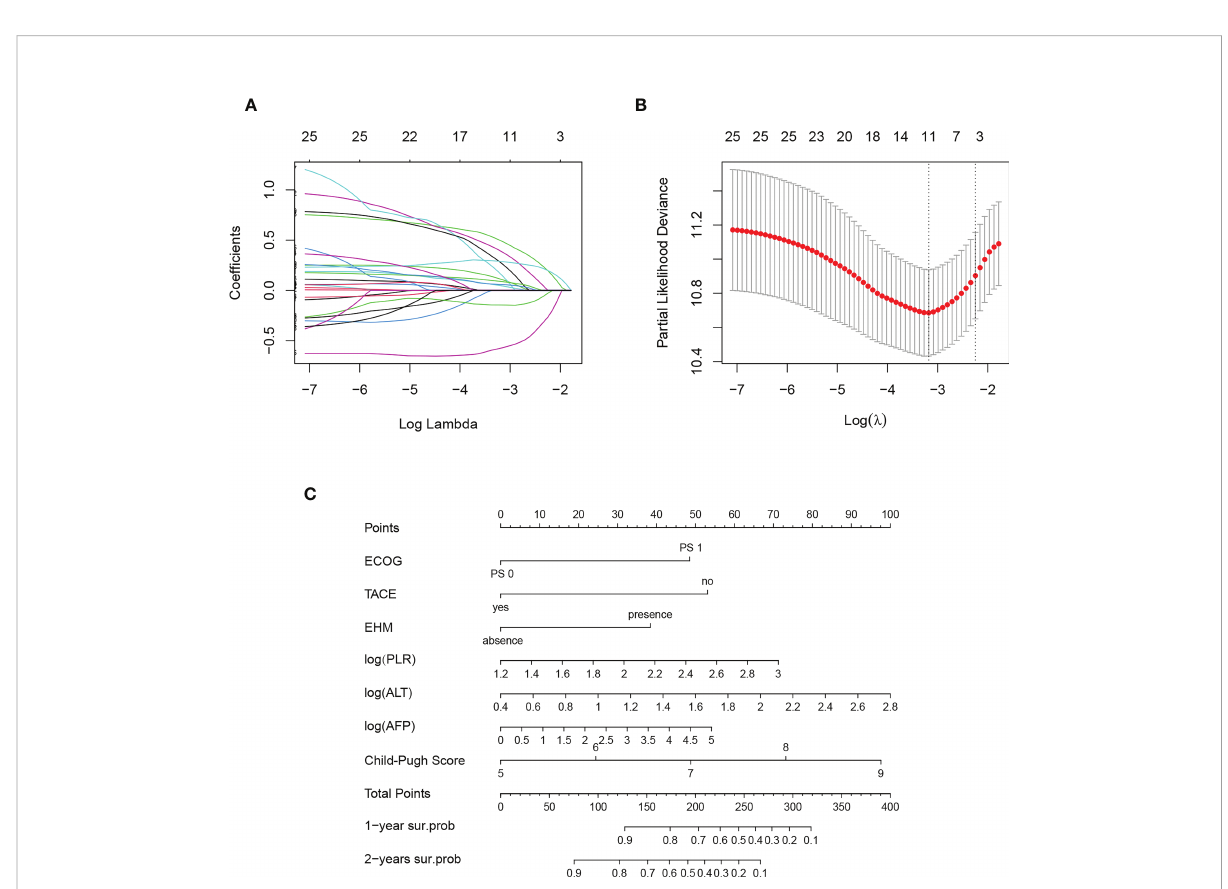
FIGURE 3 Result of Lasso regression (A, B) and nomogram for combination regimen for unresectable hepatocellular carcinoma (C)